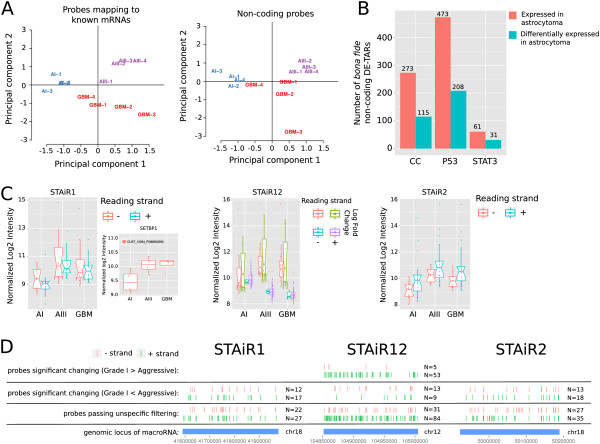
Disease-associated ncRNAs. The custom microarray was used with diffuse astrocytoma samples of different grades. (A) Principal component analysis for probes passing non-specific filtering. For at least four samples, the expression of the probe must be larger than the background, where background expression is defined by the mean intensities plus three times the standard deviation of negative control spots. The probe must have a non-specific change of expression of IQR>0.5. A separate principal components analysis was done for probes mapping to exons of known protein-coding genes (Gencode v12) and probes for which no evidence of short open reading frames was detected (see Materials and methods). The first two principal components accounted for 55% and 63% of overall variation, for probes mapping to exons of protein-coding genes and bona fide non-coding probes, respectively. (B) Number of bona fide non-coding DE-TARs either expressed in astrocytoma, i.e. overlapping at least one probe with an intensity larger than the background intensity for at least four samples, or differentially expressed in astrocytoma, i.e. overlapping at least one probe significantly differentially expressed between astrocytoma of grade I and aggressive states of grades III and IV (glioblastoma) (FDR<0.05). (C) Box plots depicting normalized log2 intensities of all probes significantly regulated in astrocytoma (grade I compared to aggressive states, FDR<0.05) and located in the genomic loci of three selected macroRNAs, STAiR1, STAiR12 and STAiR2. Notches depict 95% confidence interval of the median intensity. Normalized log2 intensities of a significantly regulated probe corresponding to SETBP1, a gene proximal to STAiR1, is shown next to the STAiR1 plot. (D) Overview of probe positions of probes located in the genomic loci of STAiR1, STAiR12 or STAiR2. CC, cell cycle; DE-TAR, significantly differentially expressed transcriptionally active region; GBM, glioblastoma; IQR, interquartile range; STAiR, STAT3-induced RNA; STAT3, signal transducer and activator of transcription-3.